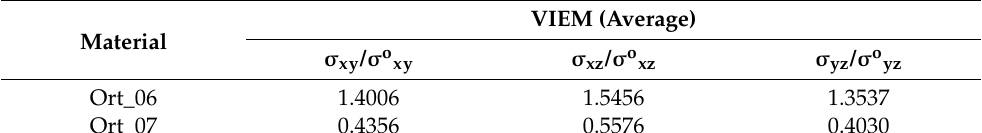
Table 19. Normalized shear stress components ( σ xy / σ o xy , σ xz / σ o xz and σ yz / σ o yz ) within the orthotropic spherical inclusion due to remote shear loading ( σ o xy , σ o xz and σ o yz ).